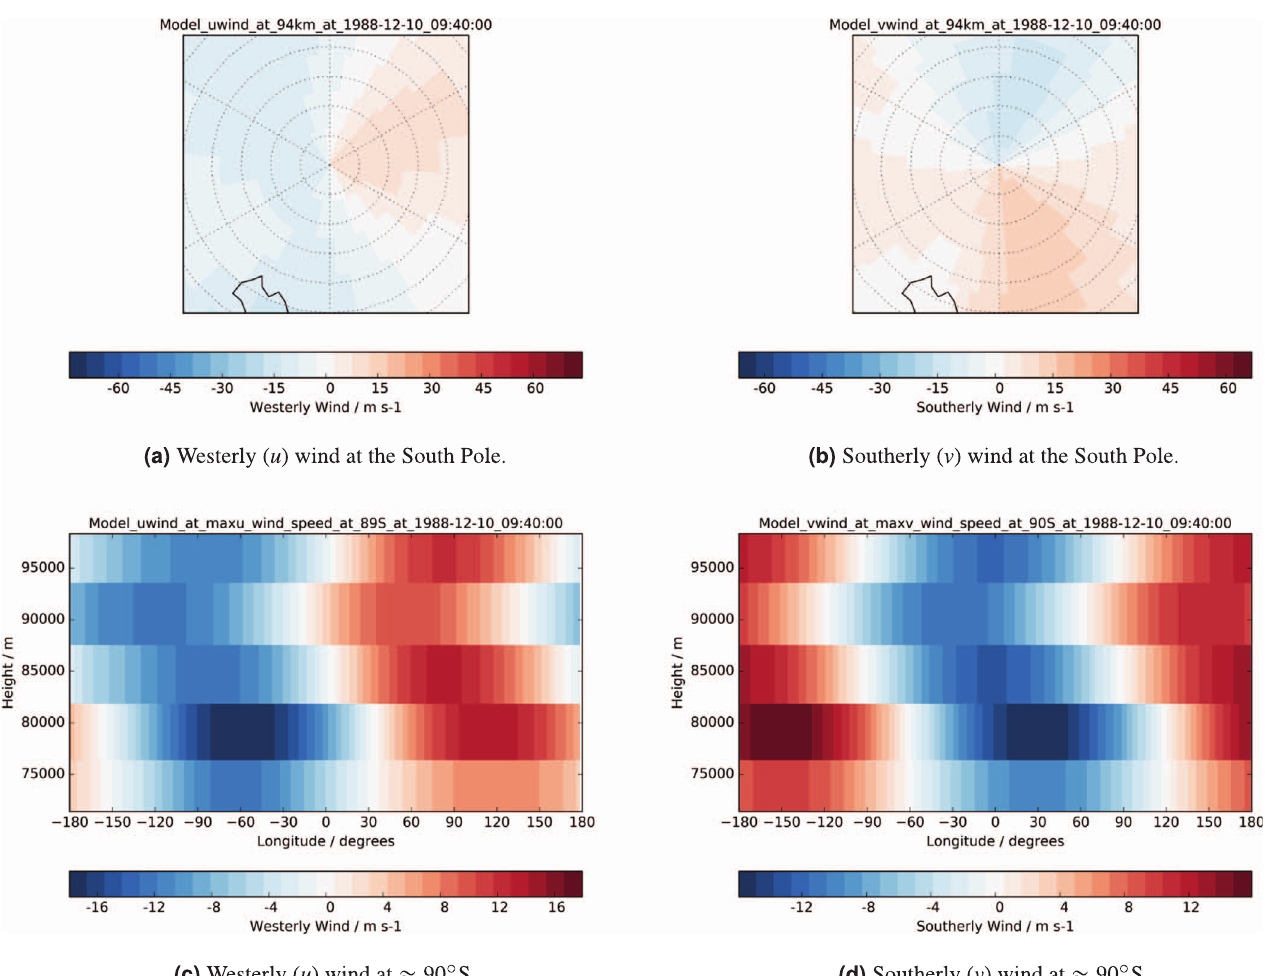
Fig. 10. Modelled wind in the 100 km September model run with the nudging scheme in place. Stereographic plots at the uppermost model level (a) and (b). Plots of the wind at the southernmost latitude circle (c) and (d). We see the removal of the anomalous wind speeds present previously by comparison with Figure